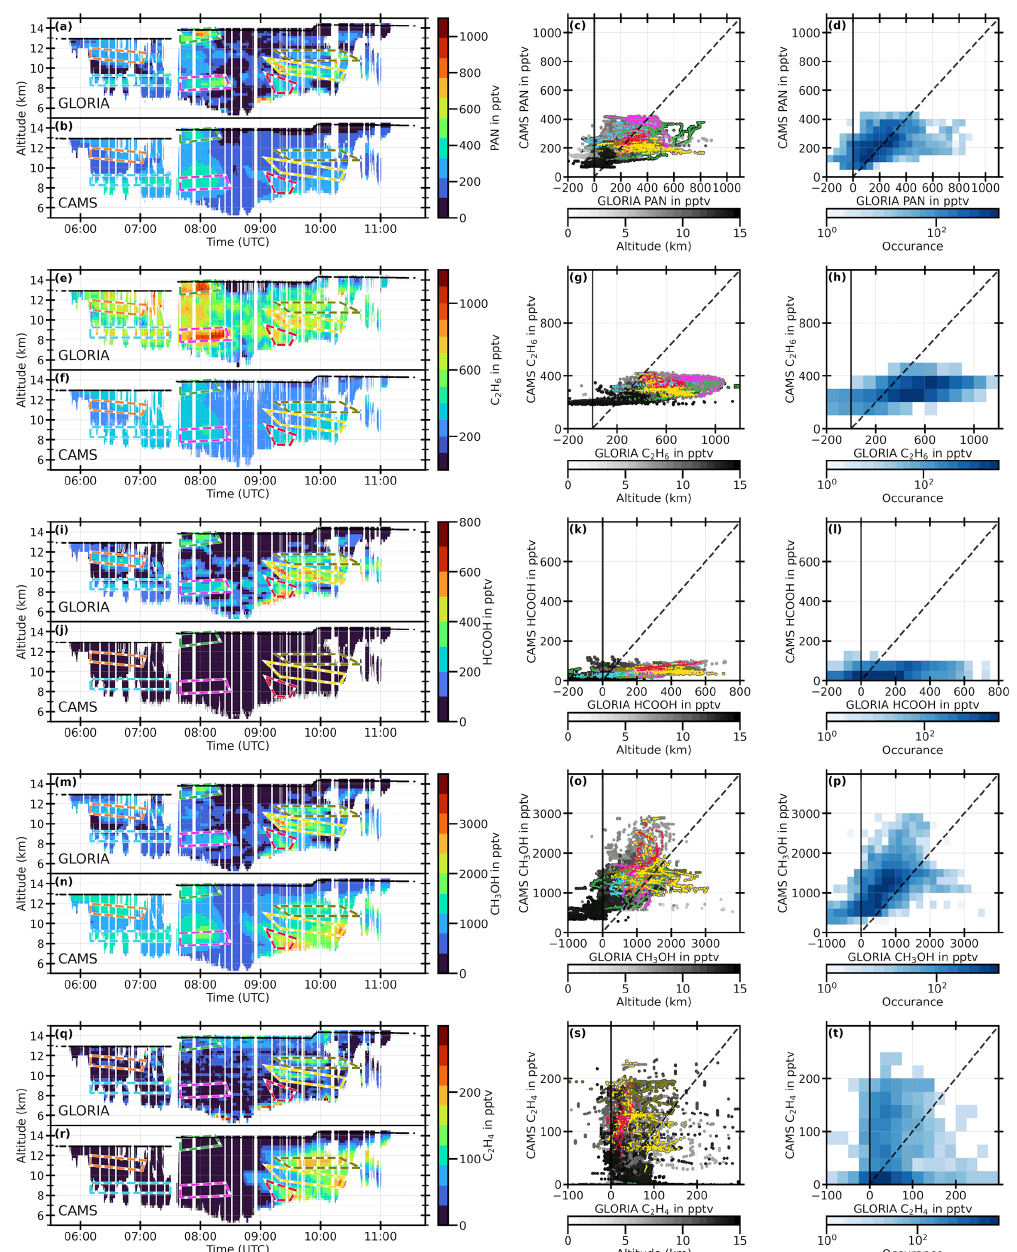
Figure 4. Comparison of GLORIA PAN (a–d) , C 2 H 6 (e–h) , HCOOH (i–l) , CH 3 OH (m–p) , and C 2 H 4 (q–t) measurements to interpolated CAMS simulation results during SouthTRAC flight on 8 September 2019. In the left column, measurement and interpolated model results are compared as cross sections. Colored boxes mark regions with measurements of enhanced pollution trace gases and are repeated from Fig. 1. Panels in the second column show single point correlations, color coded by altitude, while panels on the right display the occurrence of these correlation points in fixed